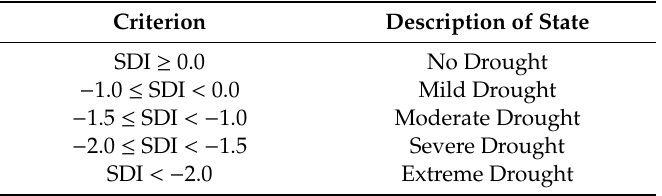
Table 2. Definition of states of hydrological drought with